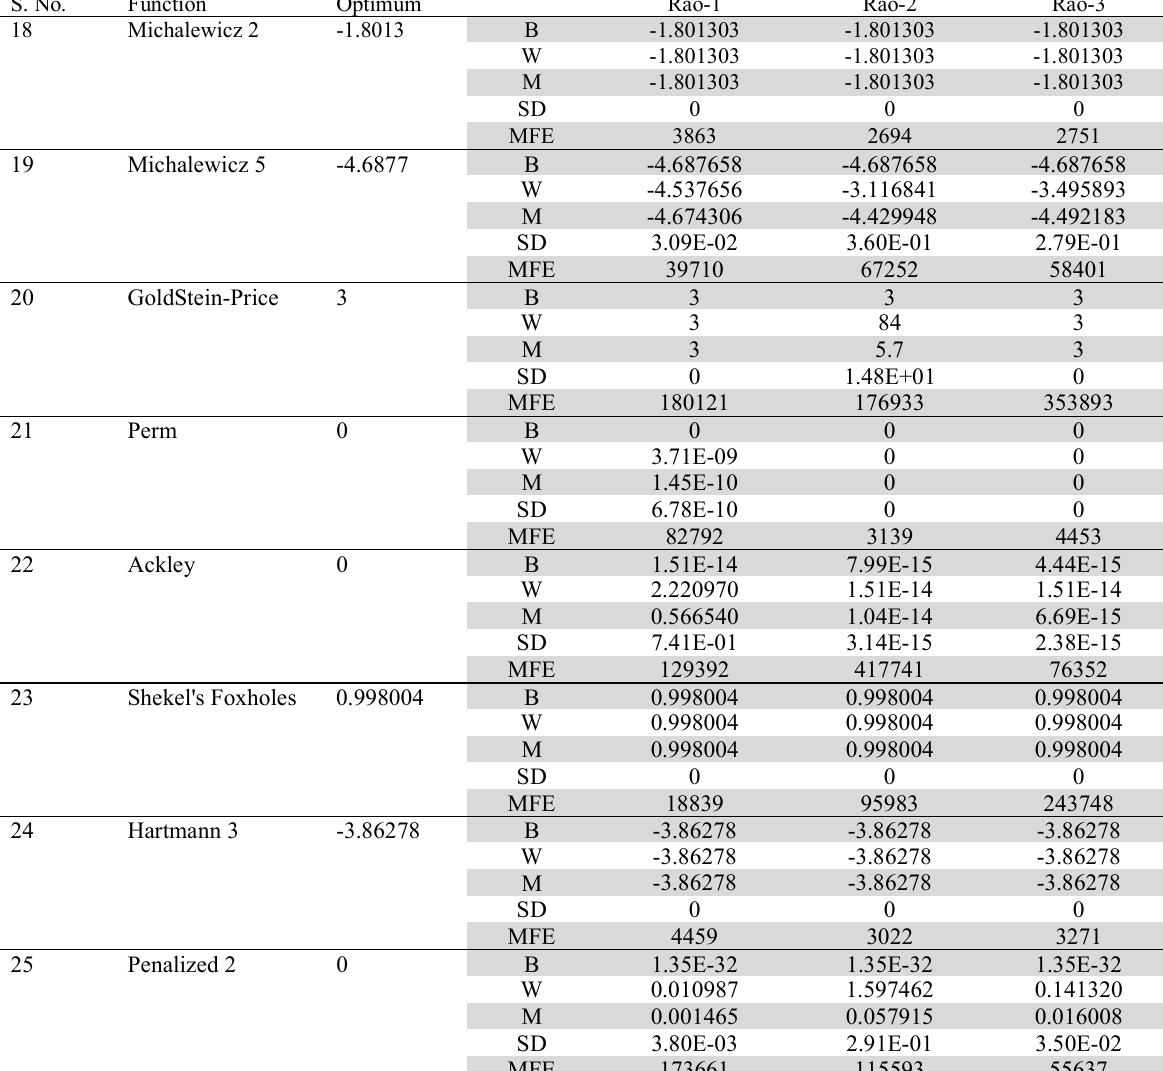
Results of the proposed algorithms for the unconstrained benchmark functions (Continued) S. No.